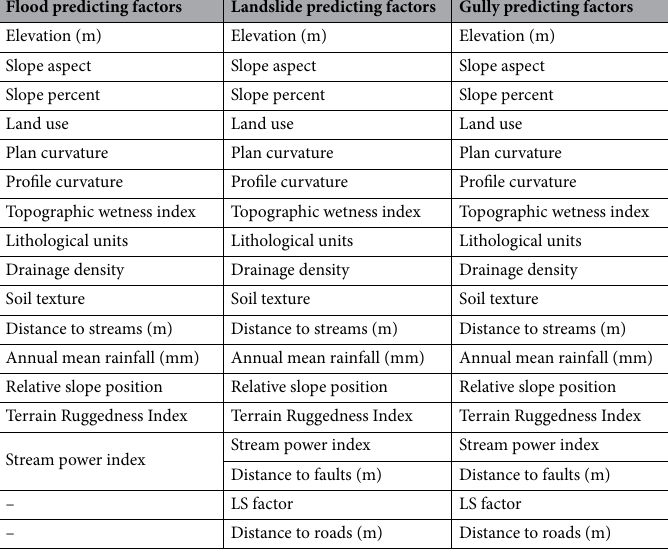
Table 2. Predicting factors for the three selected hazards in the study